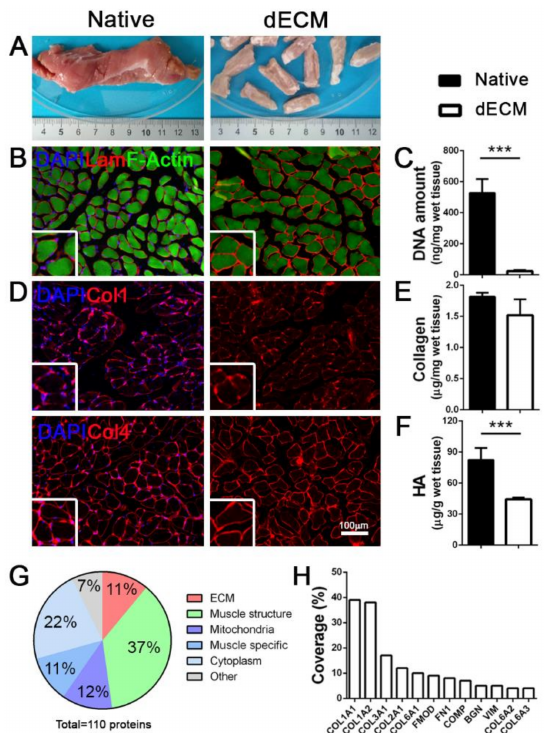
Figure 1. Porcine decellularized diaphragmatic muscle tissue characterization. ( A ) Gross